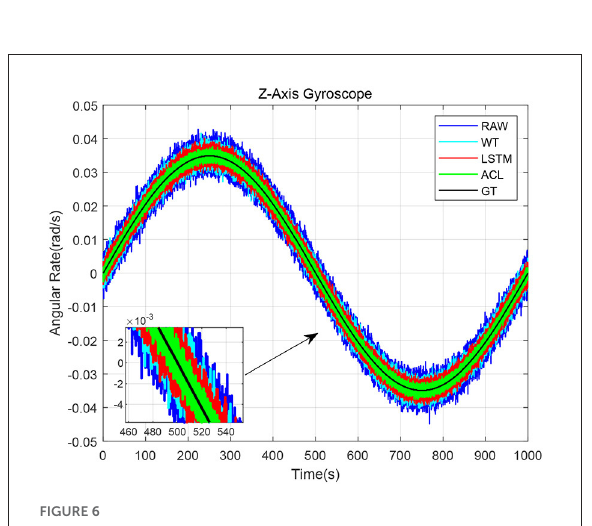
FIGURE6 The results of dynamic tests for the